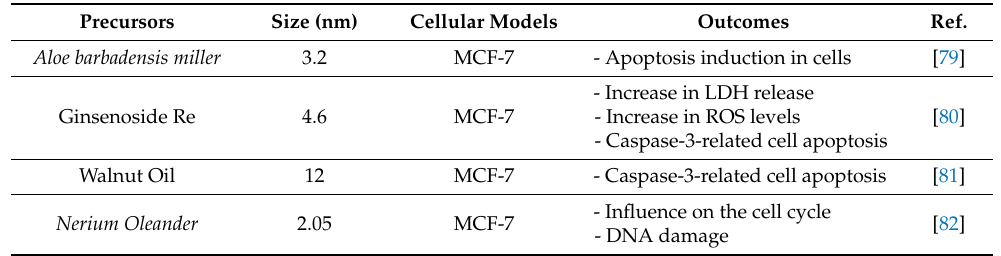
Table 3. Studies evaluating the therapeutic impact of CQDs derived from biomolecules and medicinal plants on breast cancer cells. Precursors Size (nm) Cellular Models Outcomes